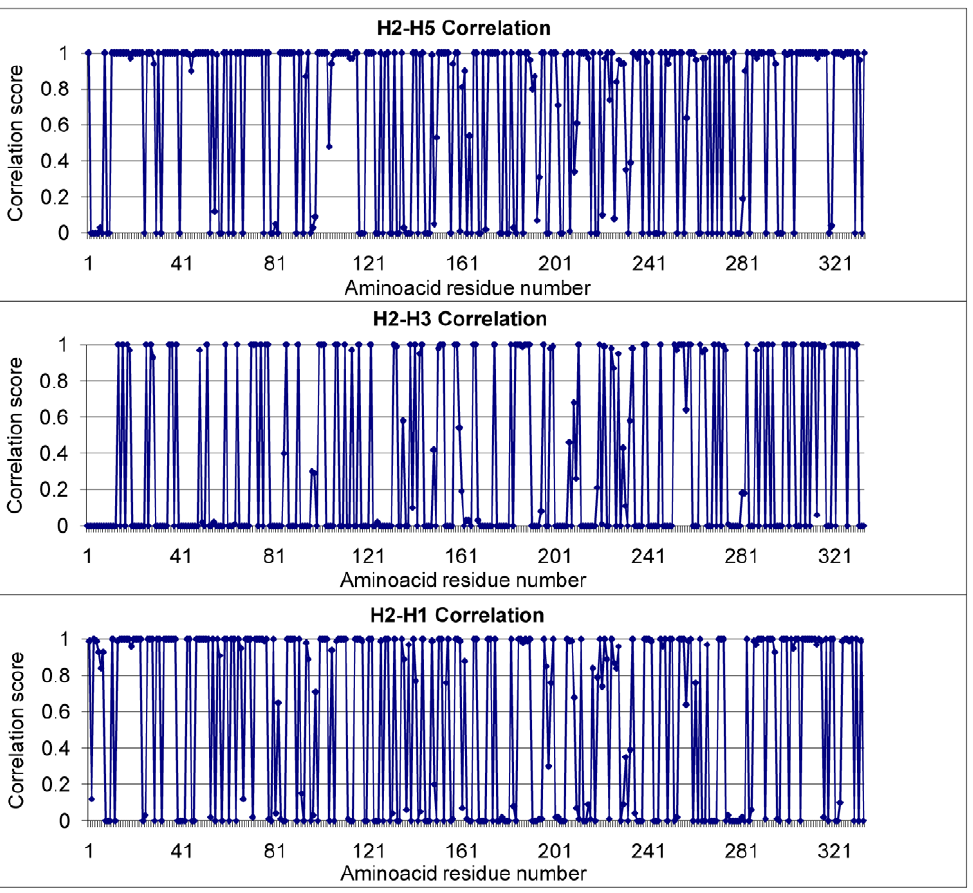
Figure 1. Correlation plots of Influenza A subtypes. Correlation of H2-H5, H2-H3 and H2-H1 in HA1 domain are shown. H3 residue numbering was followed in this analysis.